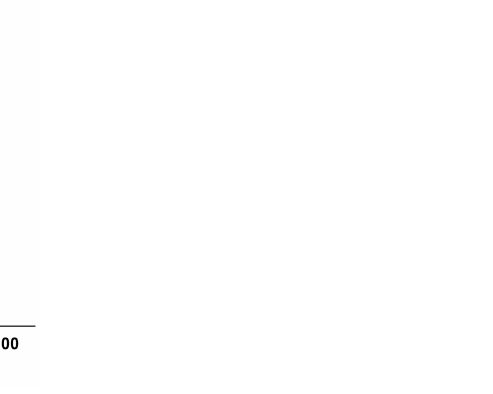
Figure 7. Effect of r 2 on %RE of RIF from aqueous bulk solution through water/DMSOT/IPA/CMC8 nanoemulsions.